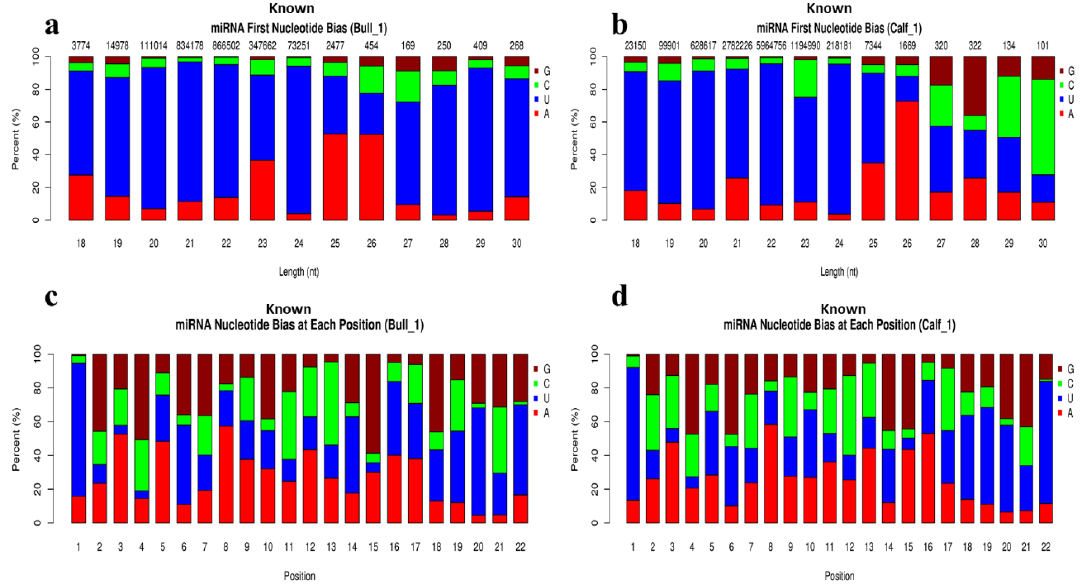
Figure 3. The first nucleotide bias, and bias at each position of known miRNAs were found in bull and calf testes. ( a ) The X-axis represents the length of known miRNAs and Y-axis shows the percent ratio of G/C/U and A bases. ( b ) Shown the analysis of first base preference at calf testes sample. ( c ) Exhibits the nucleotide bias at each position in bull testes and, ( d ) The abscissa shows the position of nucleotide in miRNAs, and ordinate presents responding percentages ratio of G/C/U/A bases each nucleotide in calf testes.